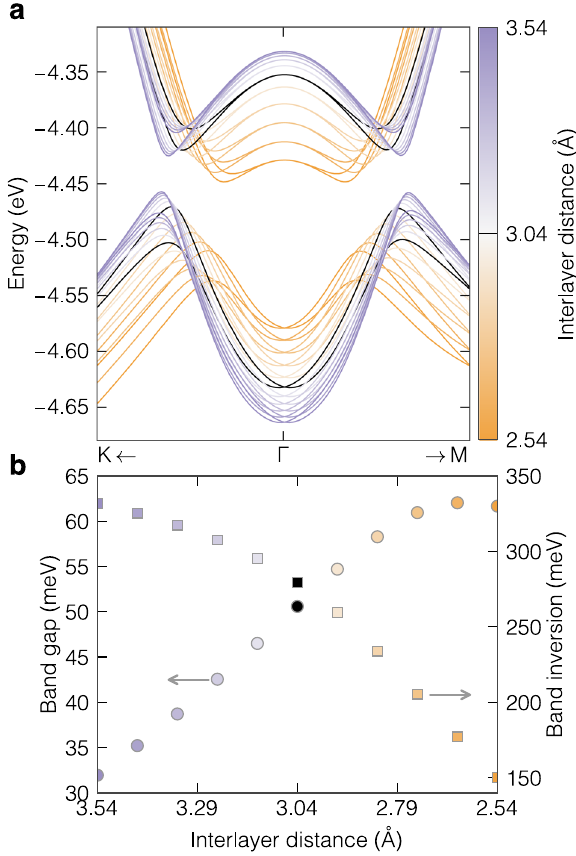
Fig. 5 Band structure evolution with interlayer distance. a Energy bands of the In 2 Se 3 /CuI heterostructure around Γ computed at the PBE-DFT level including spin-orbit coupling at different interlayer distances (color codes) around the equilibrium value. b Energy gap (circles, left axis) and band inversion at Γ (squares, right axis) between valence and conduction bands as a function of interlayer distance. In a and b results for the equilibrium interlayer distance are reported in black. Upon compression, the band inversion decreases but the interlayer coupling strongly increases, so that the overall gap is